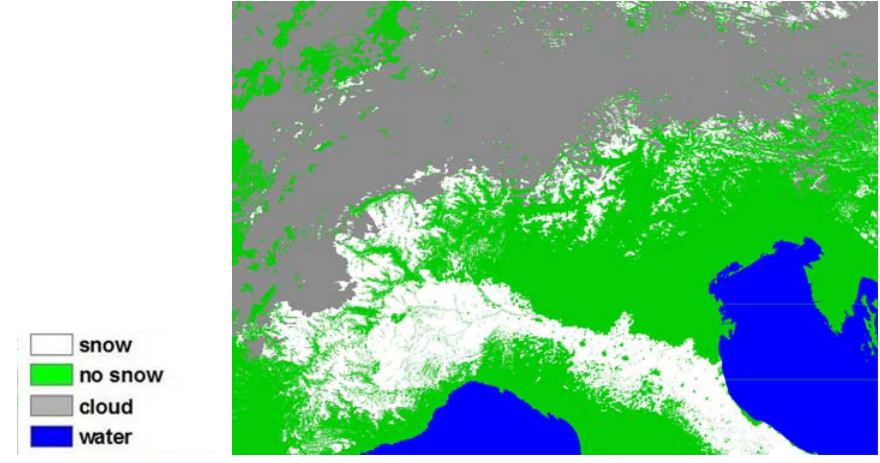
Figure 7. Example of SCA maps from MODIS (Terra and Aqua combined) data acquired over Northern Italy on 16 February 2012 obtained with the EURAC algorithm. In this SCA, the intense snowfall of the Po valley is clearly